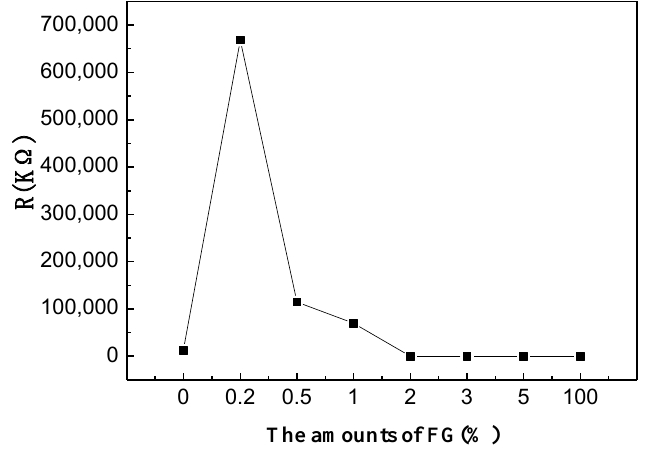
Figure 10. Responses of FG/WO nanocomposites sensors with different amounts of FG 3 to 100 ppm NO at different operating x